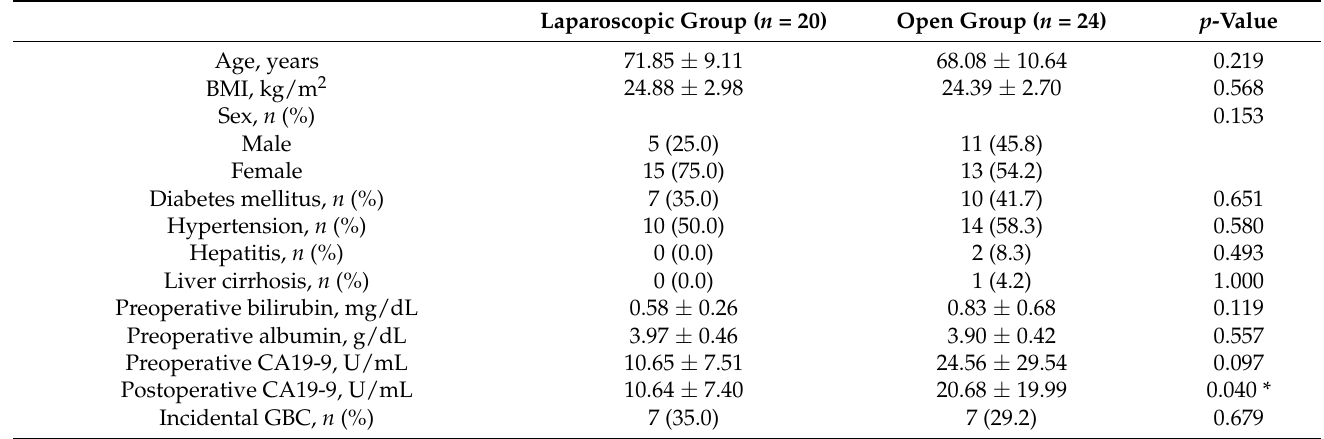
Table 1. Baseline characteristics of patients with gallbladder cancer who underwent laparoscopic and open extended